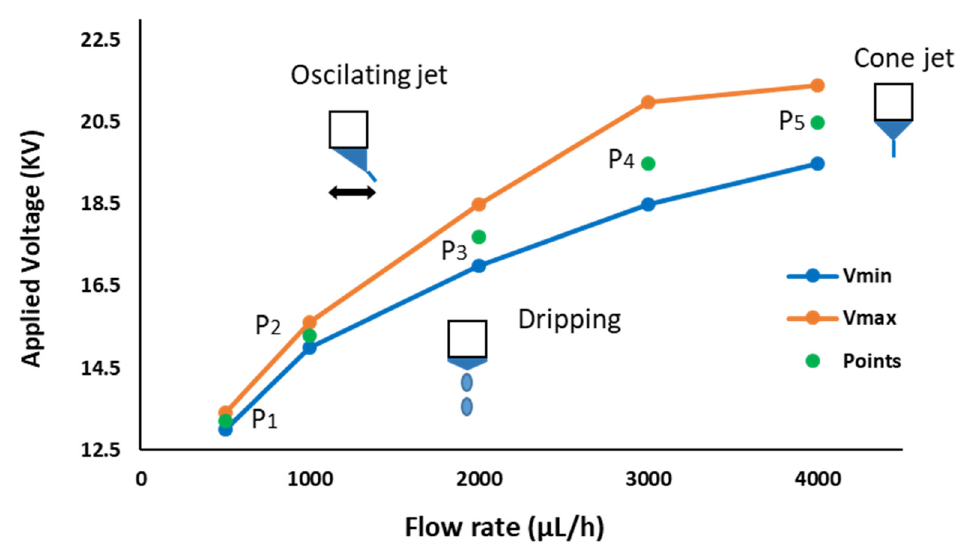
Figure 5. Operating diagram for PVDF-HFP, electrospinning jet modes: the dripping region delimited with the cone jet region by V min and the oscillating jet region delimited with the cone jet region by V max . Within the cone jet area, there are five selected samples-points to study: P1 (13.2 KV; 500 µL/h), P2 (15.5 KV; 1000 µL/h), P3 (17.7 KV; 2000 µL/h), P4 (19.5 KV; 3000 µL/h), and P5 (20.5 KV; 4000 µL/h).